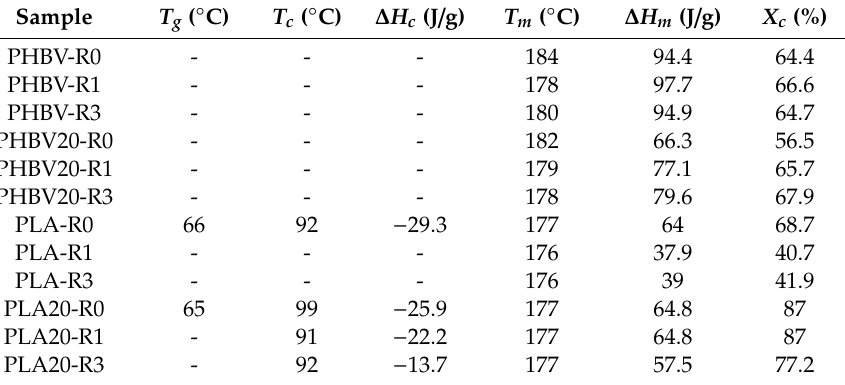
Table 3. Calorimetric results for PHBV, PLA and their biocomposites–recycled materials.